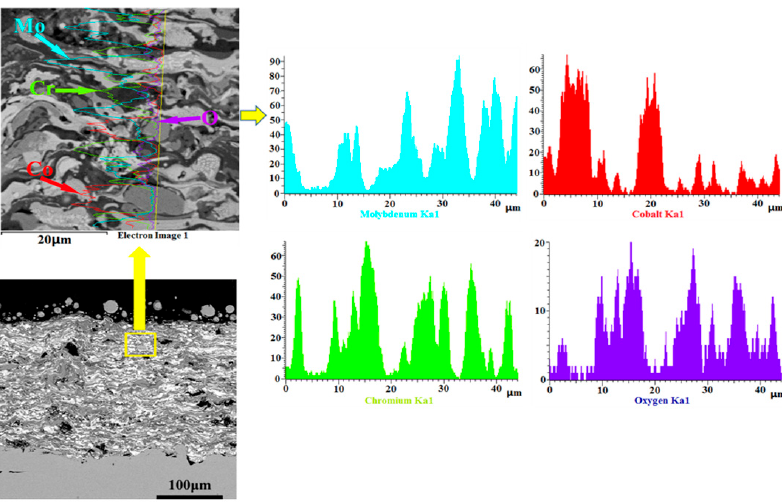
Figure 20. Scanning electron microscopy (SEM) image and energy-dispersive spectroscopy (EDS) analysis of the MoB/CoCr coating after an immersion test in molten zinc for 360 h.